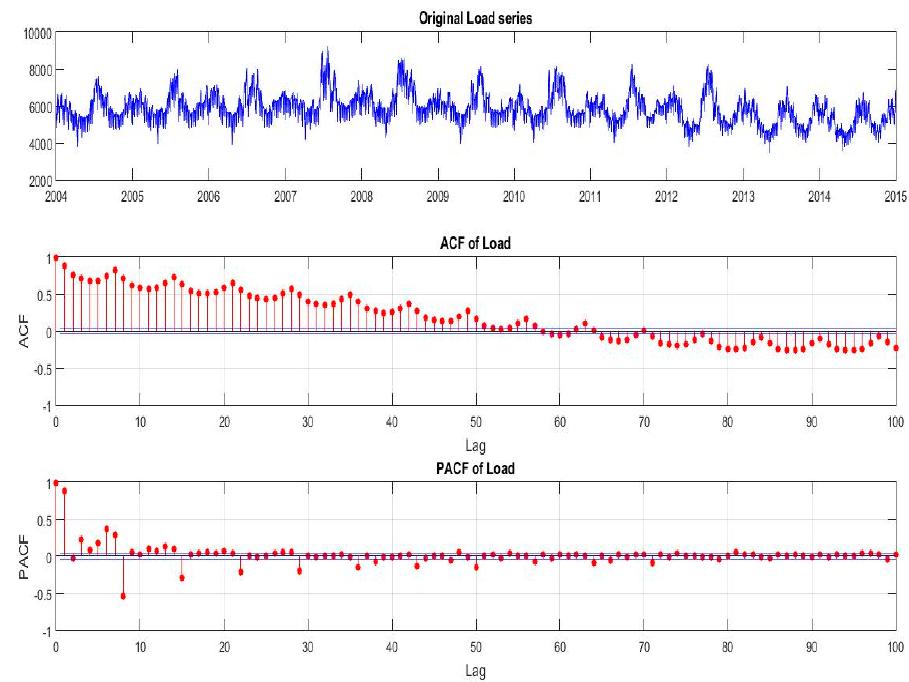
Figure 2. Daily average (of 24 h) load in Greek electricity market, 2004–2014, with its autocorrelation and partial autocorrelation functions. Table 1. Descriptive statistics of Load and predictor mean temperature in Greece.